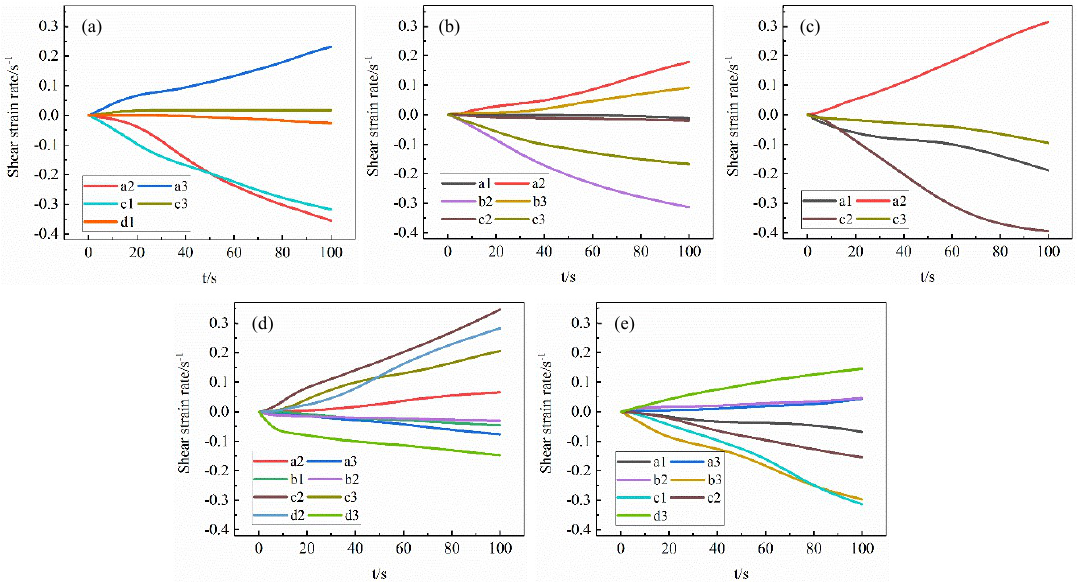
Figure 10. Shear strain rates of a node on the G411: ( a ) Brass; ( b ) Copper; ( c ) S; ( d ) Cube; ( e ) Goss.